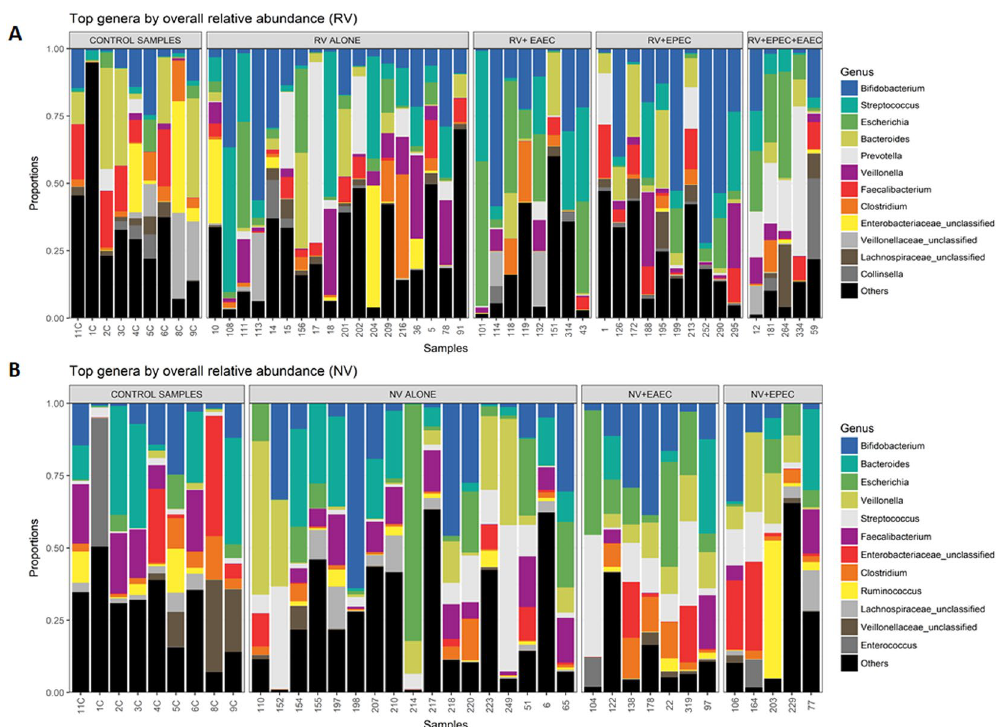
Figure 1. Community clustering and composition of top genera of bacterial species and their overall relative abundance in 79 children. All gut microbiota OTU profiles of the patients were aggregated into genera and plotted. “Other” under the genus represents lower-abundance taxa. Optimal number of consensus taxonomy was obtained for each OTU and 12 most abundant genera were displayed. ( A ) Clustering and composition of top 12 genera in RV cohort in comparison with control group. ( B ) Clustering and composition of top 12 genera in NoV cohort in comparison with control